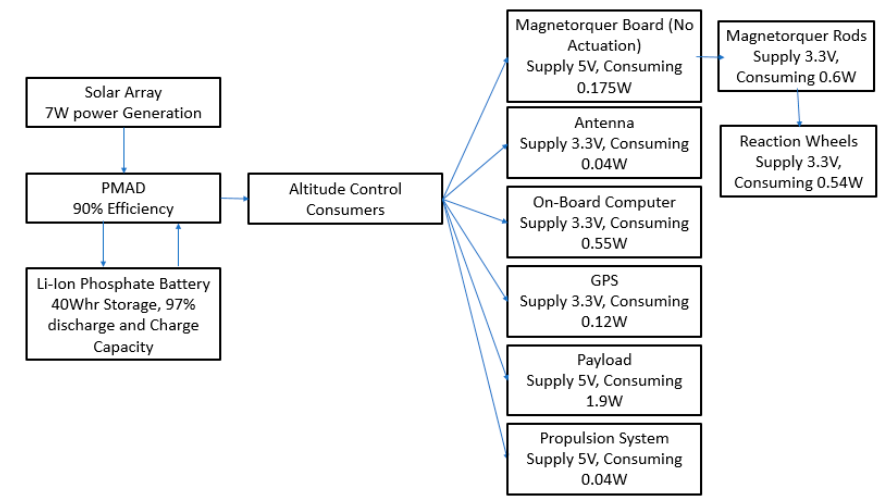
Figure 41. Altitude Control Scenario Block Diagram.